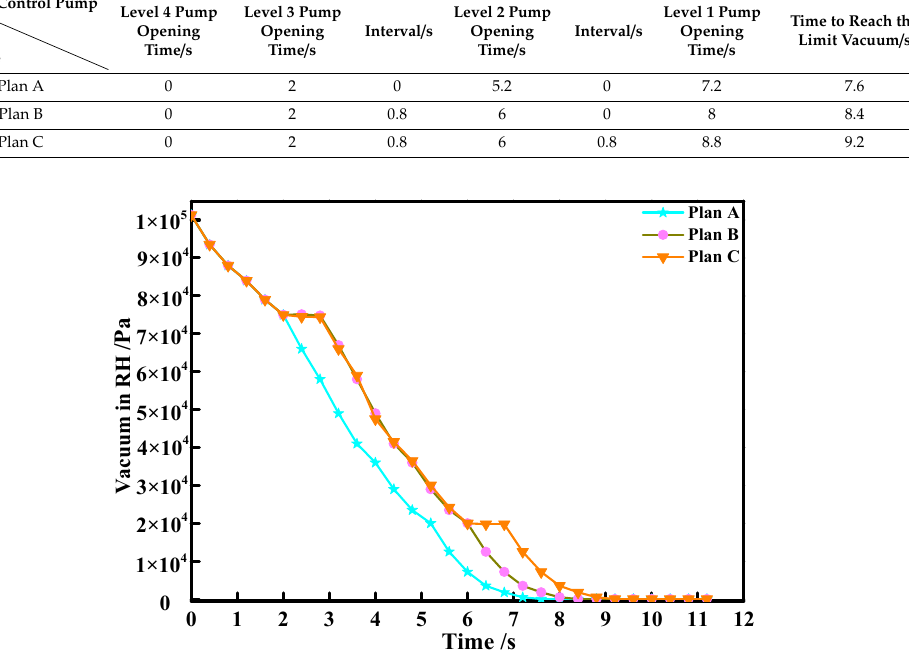
Figure 2. Di ff erent vacuum pressure drop Figure 2. Different vacuum pressure drop modes.